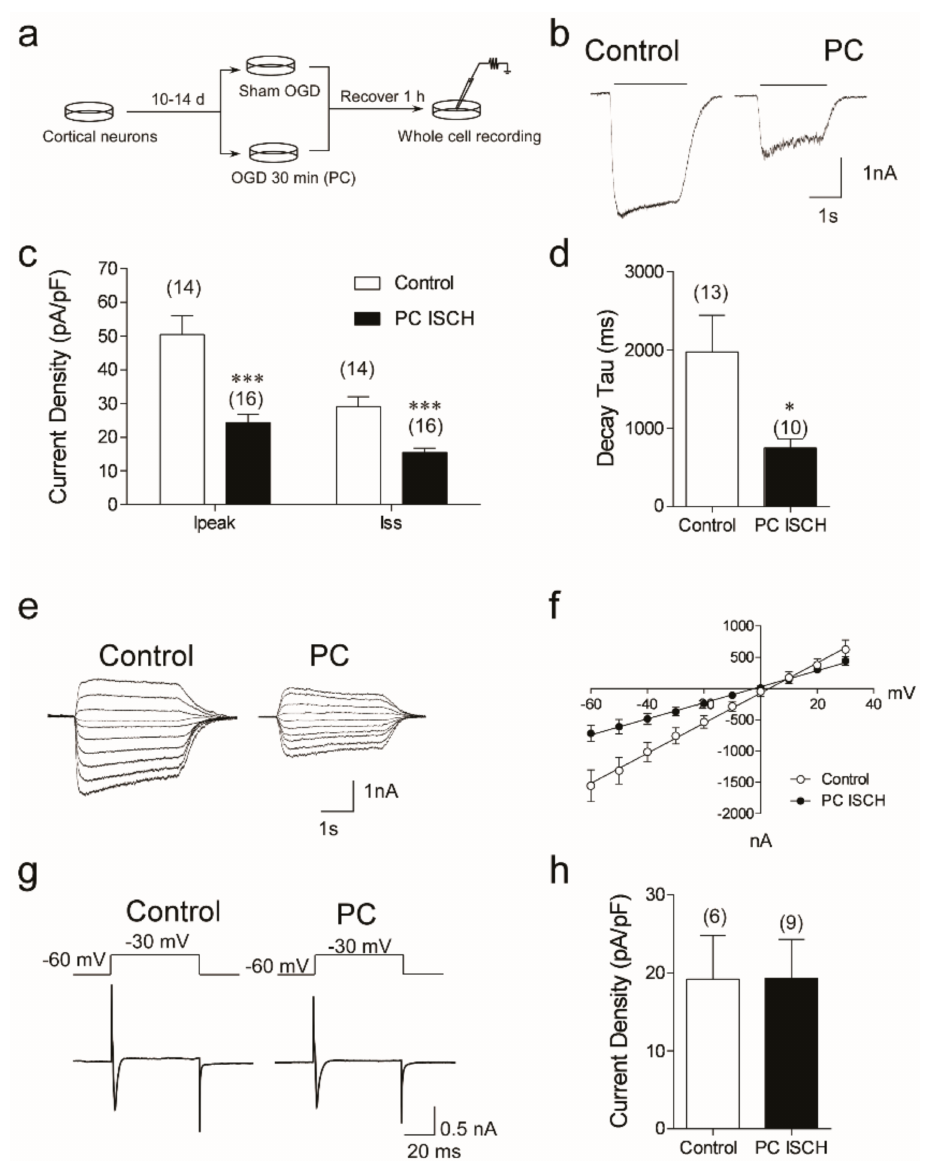
Figure 1. Ischemia preconditioning induces NMDA current reduction in cultured cortical neurons. ( a ) Primary cultured cortical neurons of 10–14 DIV were treated with either 30 min OGD or sham OGD followed by 1 h of recovery in normoxic incubator before they were used for whole-cell recording. ( b ) Representative traces of whole-cell currents evoked with 100 µ M NMDA in control and PC neurons. Neurons were held at − 60 mV and currents were recorded in ECF containing 1 µ M TTX and 3 µ M Gly. ( c ) The current densities of NMDA-evoked currents in control